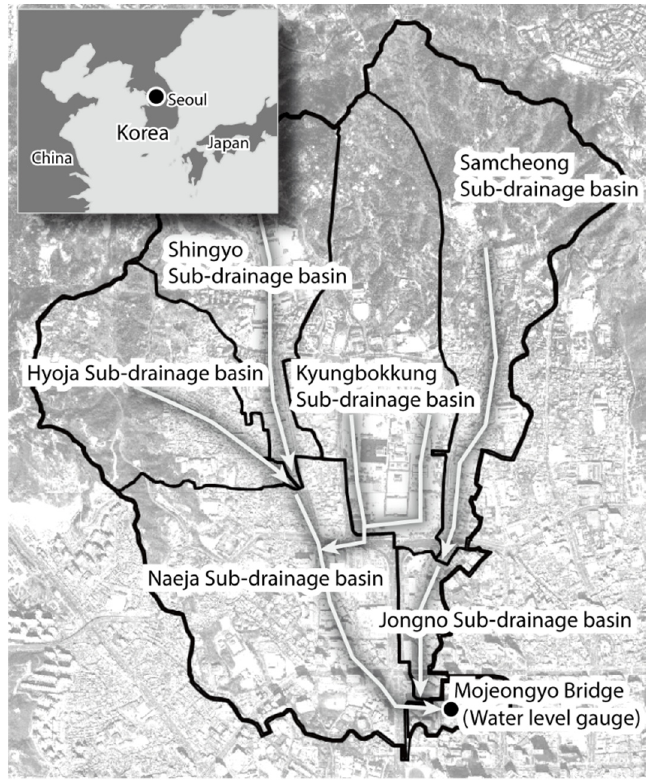
Figure 5. The drainage network of the Hyoja drainage basin.